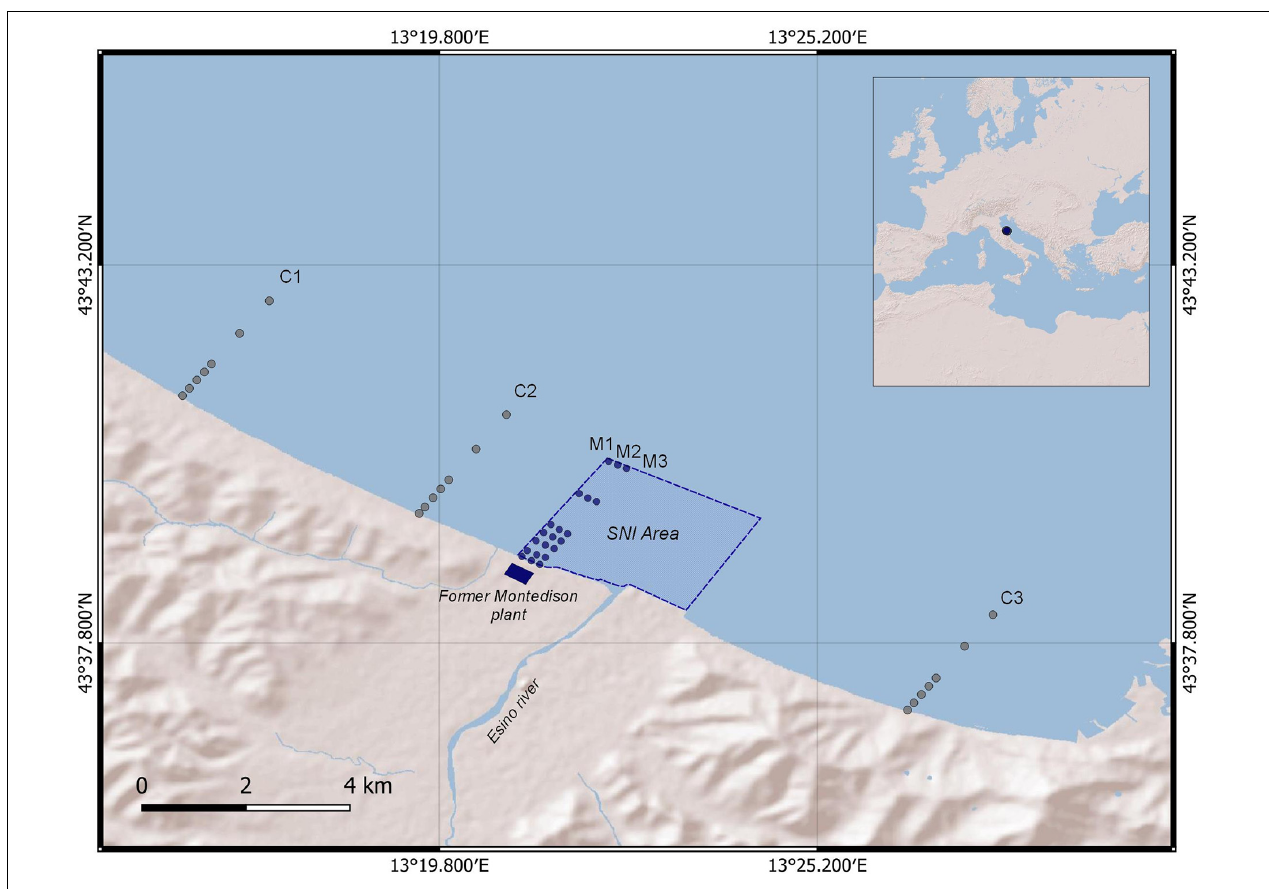
FIGURE 1 | Sampling site and study area. The stations of the control transects (C1, C2, and C3) are represented as gray dots, the SNI transects (M1, M2, and M3) as blue dots and the perimeter of the SNI area as a blue dotted line. The small blue rectangle represents the location of the former Montedison